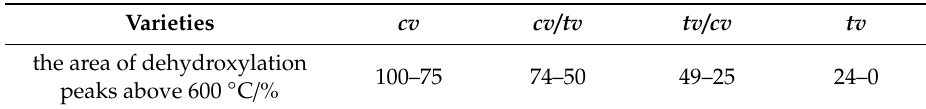
Table 3. Classification of dioctahedral smectites according to the thermal reaction (according to Wolters and Emmerich [28]).